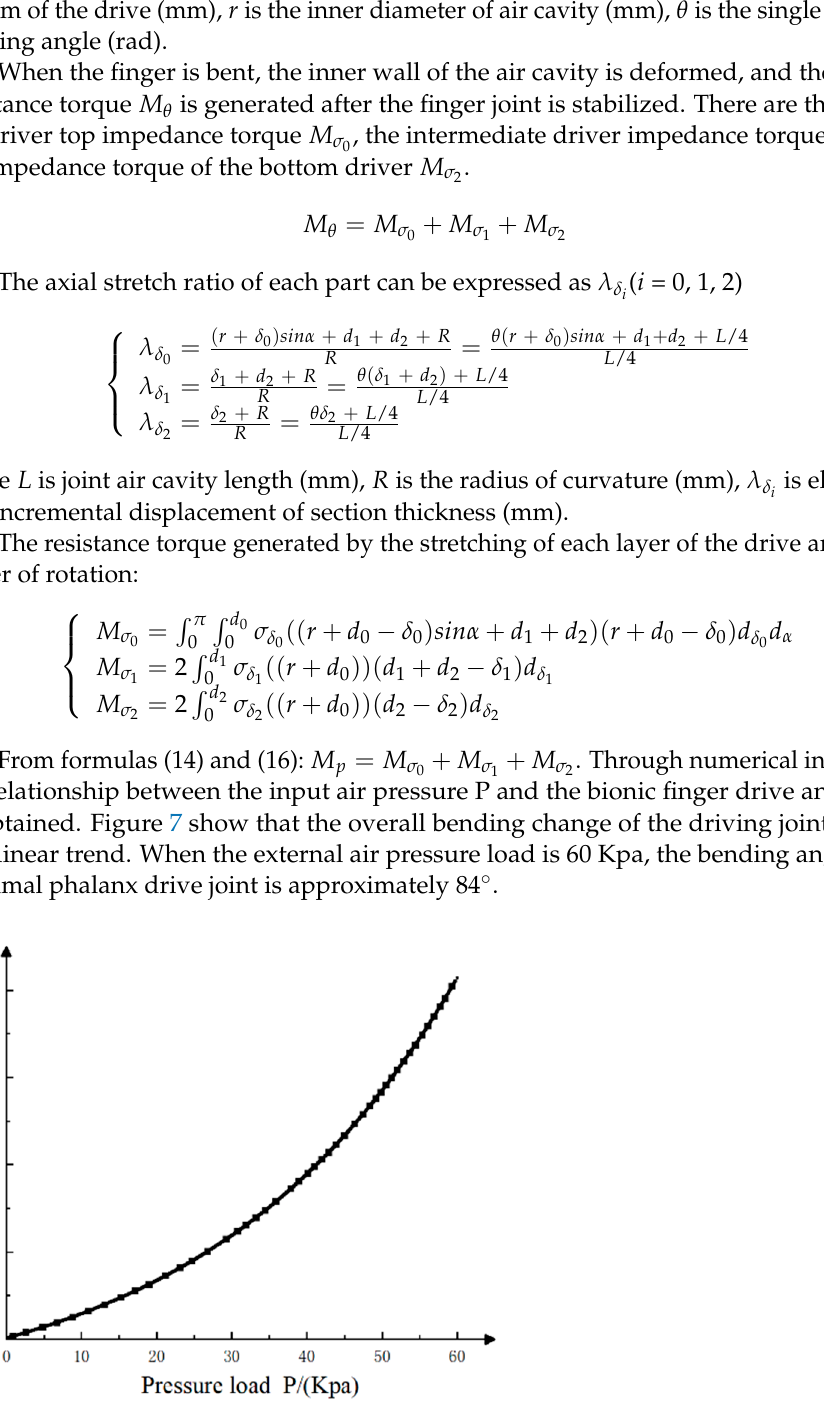
Figure 7. Relationship between air pressure and drive bending